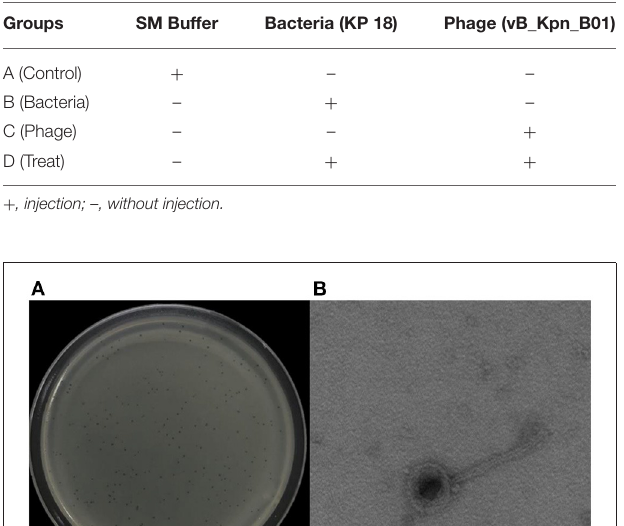
Frontiers in Veterinary Science |